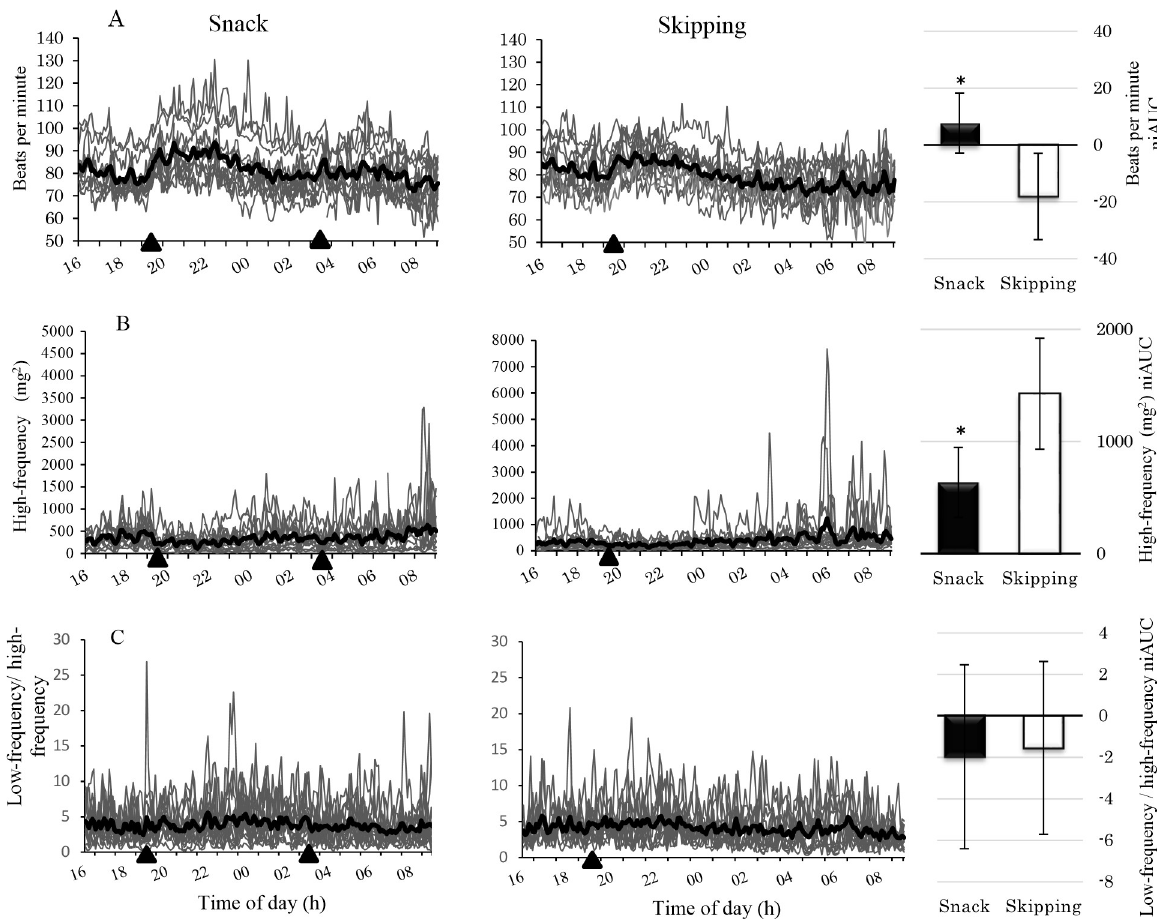
Fig 5. Heart rate, high-frequency, and low-frequency/high-frequency ratio following a simulated night shift. A-HR, B-HF. C-LF/HF, Left side and center panels display the individual data per condition from 16:00 to 09:00 testing points. The mean is shown as a thicker line over the top of the individual data. Snack condition—left side panel, Skipping condition—center panel. Black triangle ( ▲ ) indicates eating a meal at 19:30 and at 03:30. The average values of the markers in the left side and center panels match columns in the right side panels for each condition, before and after eating, from 03:00 to 09:00. Bars represent standard error. Analysis of covariance was used to assess the significance of mean differences between groups after eating ( � : p < .05).